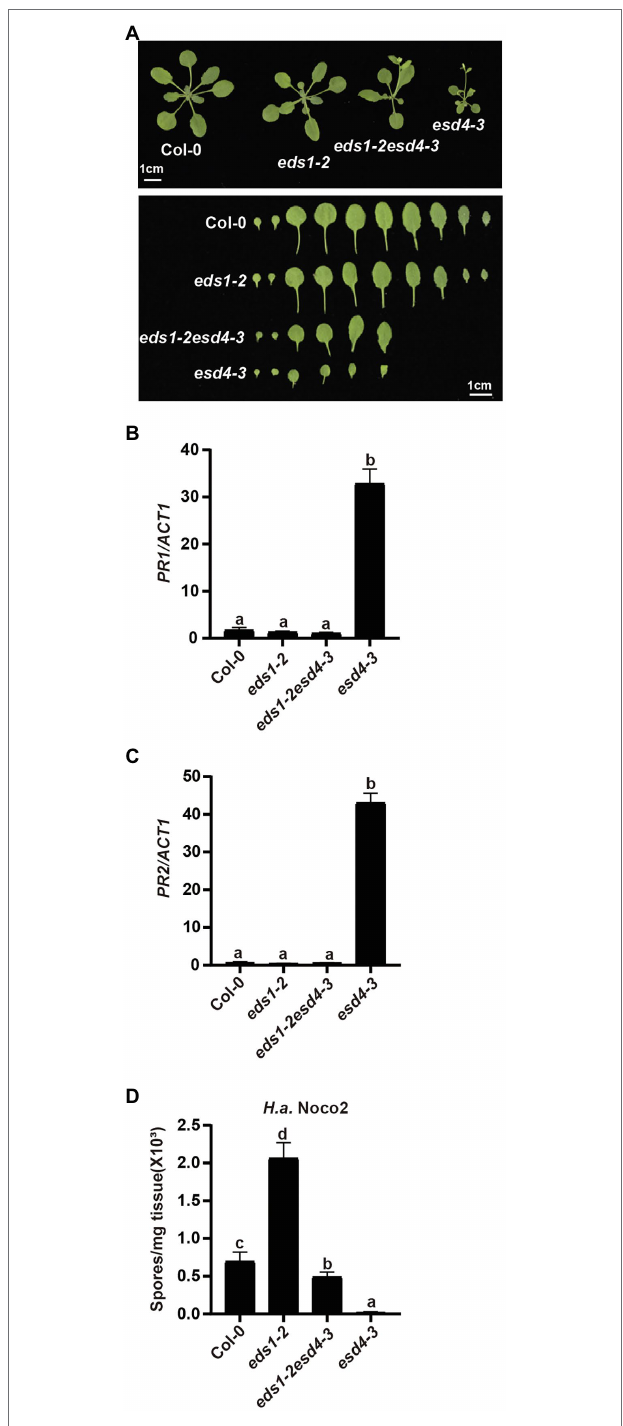
FIGURE 5 | The constitutively activated immunity in esd4 is suppressed by eds1 . (A) Morphologies of 4-week-old soil-grown plants of the indicated genotypes under long-day conditions. (B,C) Expression of PR1 (B) and PR2 (C) in indicated genotypes. ACTIN1 serves as internal control. (D) Growth of H.a. Noco2 on the indicated genotypes. The values indicate averages of replicates ± SD ( n = 3). Different letters indicate statistical differences among different samples ( p < 0.05, one-way ANOVA, n = 3). Experiments were repeated twice with similar